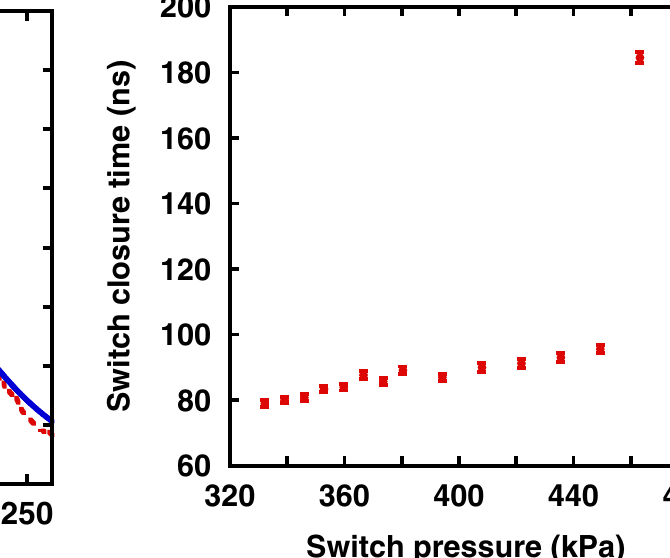
FIG. 12. (Color) Typical load voltage trace compared with a PSPICE [23] circuit code calculated voltage